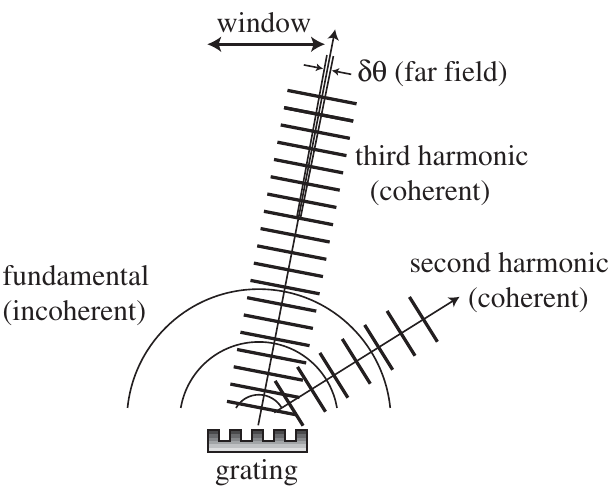
FIG. 3. Radiation pattern in the Dartmouth experiments at 35 keV (not to scale). The evanescent wave is not